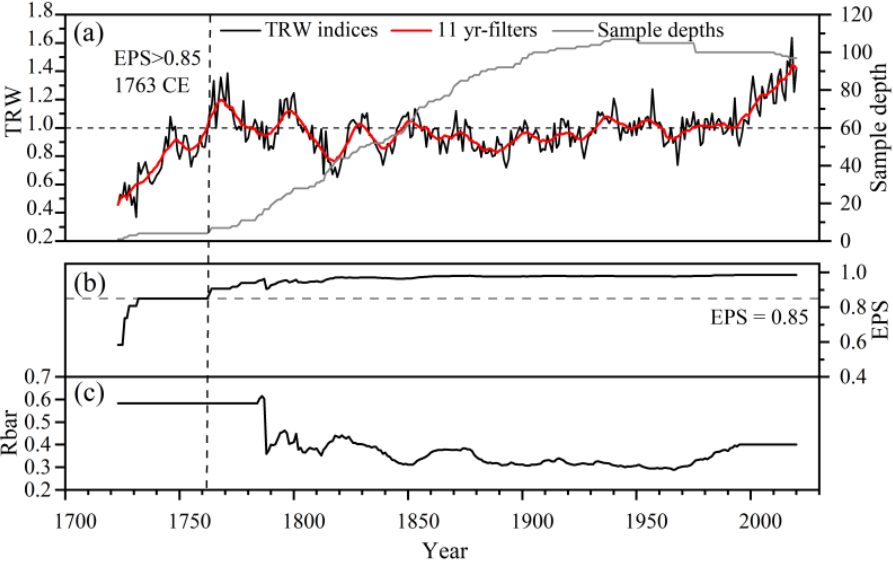
Figure 2. ( a ) Composite tree-ring width (TRW) chronology (thin black line) with an 11-year moving running average smoothing filter (heavy red line) and the sample depth (grey line); ( b ) the running expressed population signal (EPS) calculated over 51 years with a 1-year lag. The dotted line indicates the 0.85 criterion; ( c ) Rbar statistics calculated over 51 years with a 1-year lag in the chronology.